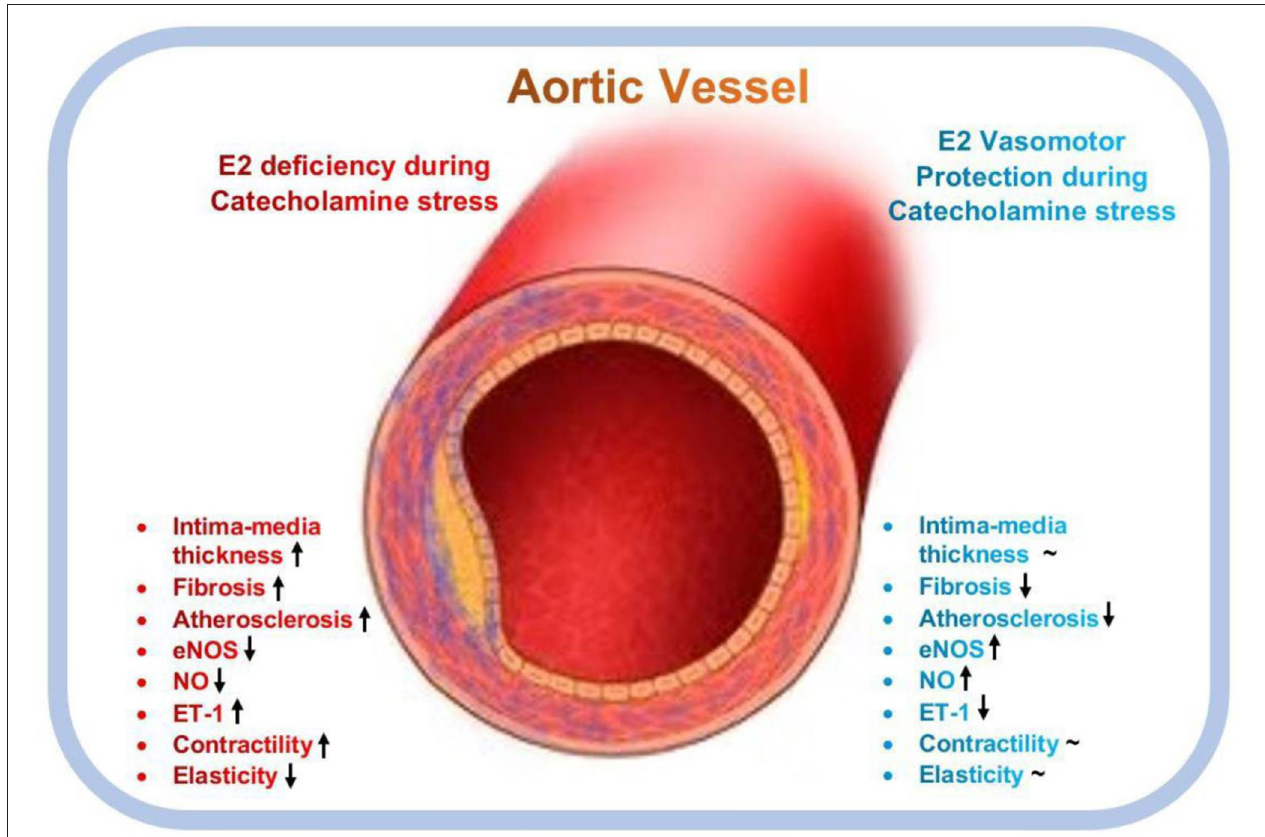
FIGURE 7 | Graphical abstract of the vasomotor function protective roles mediated by estrogen during catecholamine stress. E 2 , Estrogen; eNOS, endothelial nitric oxide synthase; ET-1, endothelial-1; NO, nitric oxide; ↑ , upregulates; ↓ , downregulates; ∼ , normalizes.